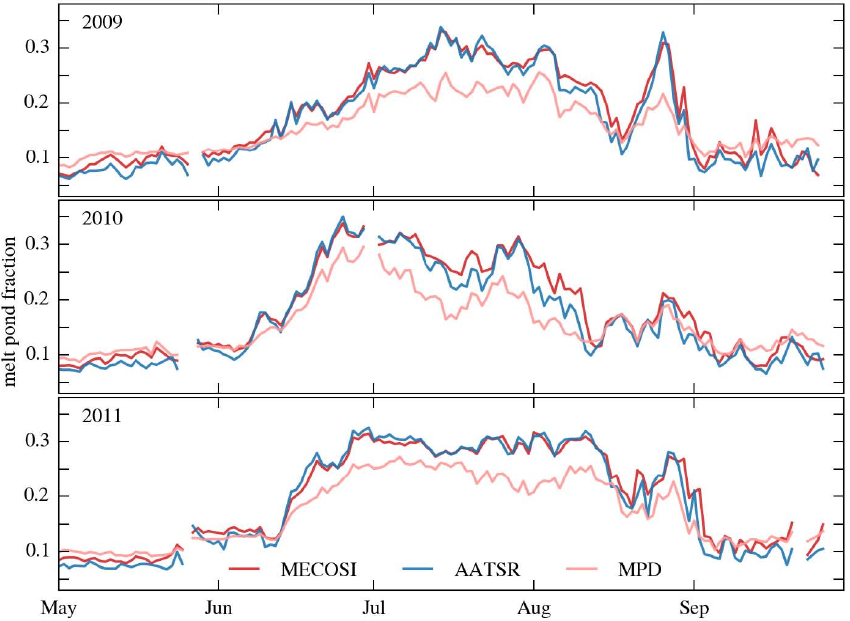
Figure 10. Influence of different cloud mask on Arctic-wide mean melt pond fraction for 2009–2011. The means are calculated from gridded melt pond fraction data and coverage is restricted to the area seen by AATSR. Days with less than 100 grid cells to compare or missing AATSR data are